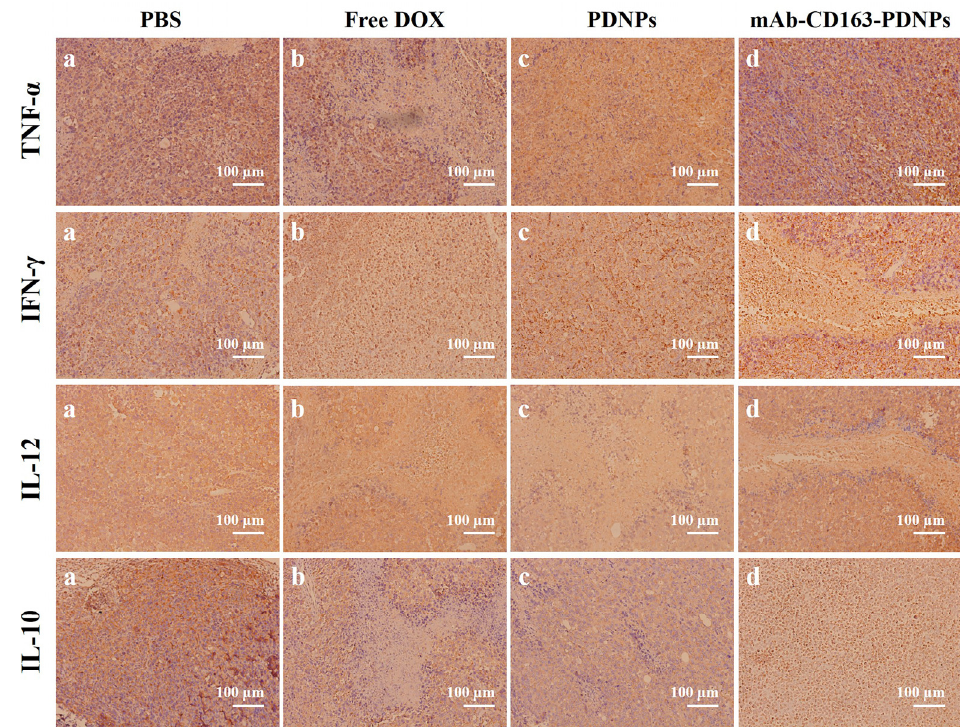
Figure 9. Immunohistochemical analysis (TNF- α , IFN- γ , IL-12 and IL-10) of mouse tumor sections: ( a ) PBS control group, ( b ) Free DOX group, ( c ) PDNPs group, and ( d ) mAb-CD163-PDNPs group.